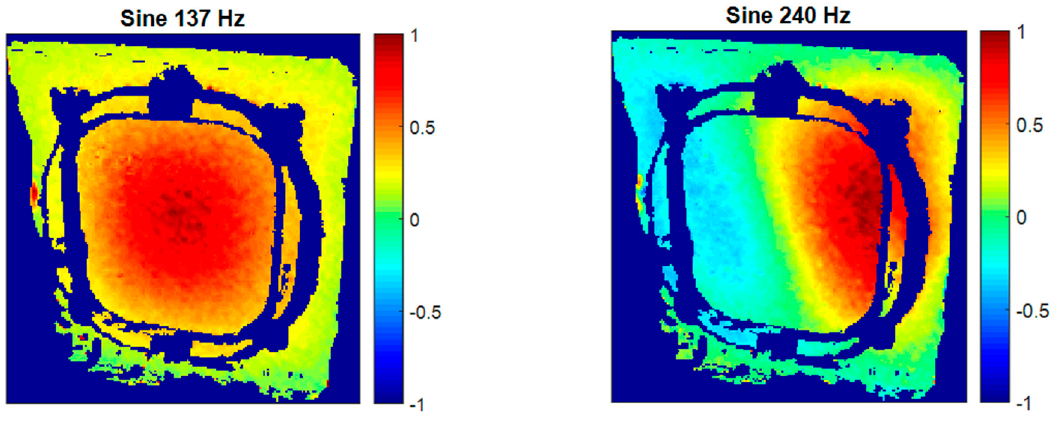
Figure 18. Operational deflection shapes of the second window specimen obtained using HS 3D-DIC in a sine test. in a sine